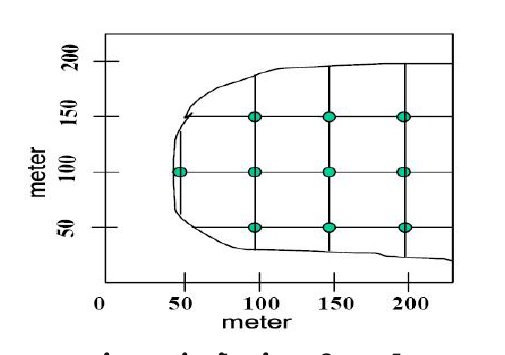
Fig.1: Distribution of